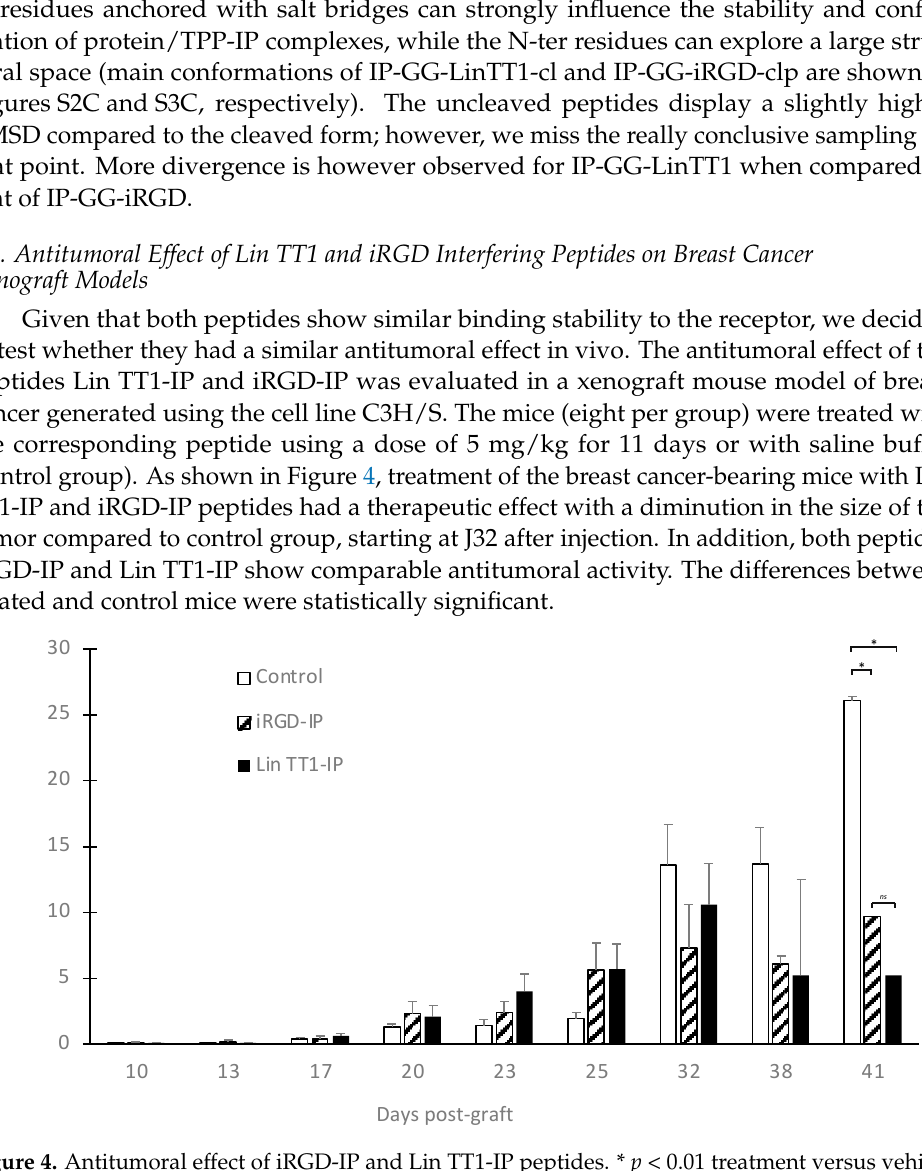
Figure 4. Antitumoral effect of iRGD-IP and Lin TT1-IP peptides. * p < 0.01 treatment versus vehicle control group. ns: no significant.